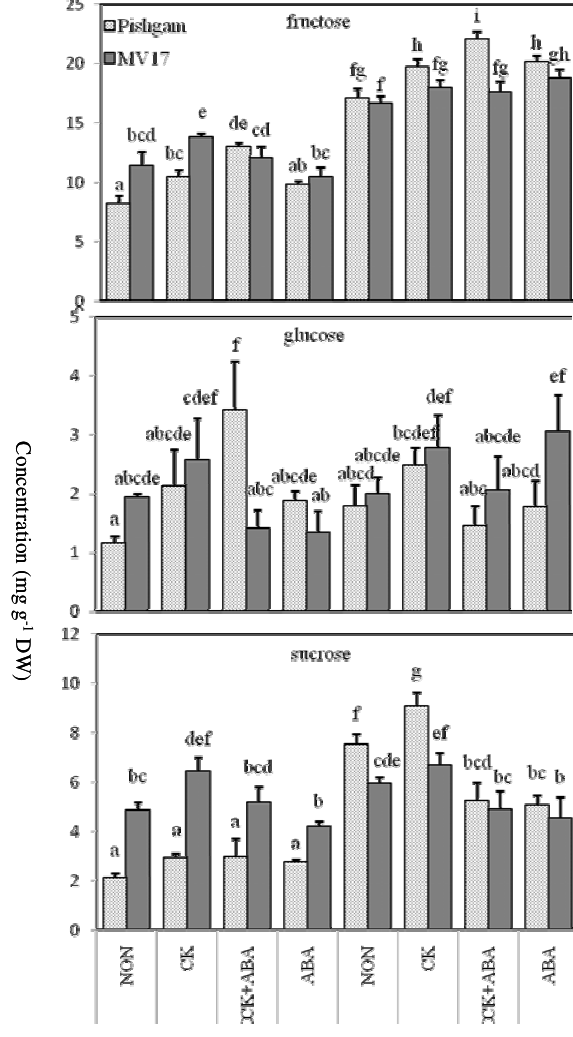
Fig. 2. Effect of hormonal treatments of CK, ABA and CK/ABA on fructose, glucose and sucrose content under irrigation and drought condition in flag leaves during grain filling in two wheat cultivars (drought tolerant cv. ‘ Pishgam ’ (white columns) and drought sensitive cv. ‘ MV-17 ’ (black columns). Data are shown as mean ± SD of three independent